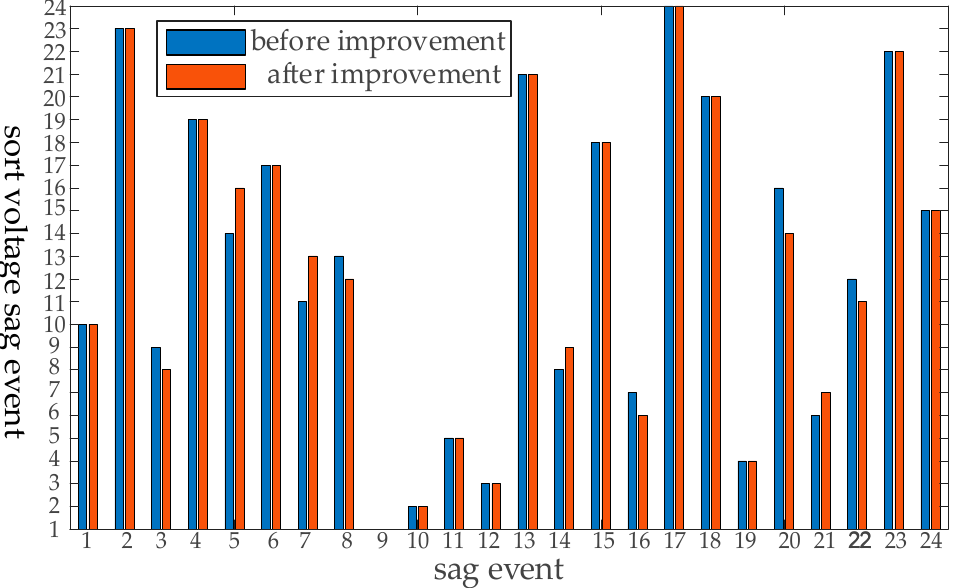
The severity of MSDI and S e is sorted and compared with the improved energy index